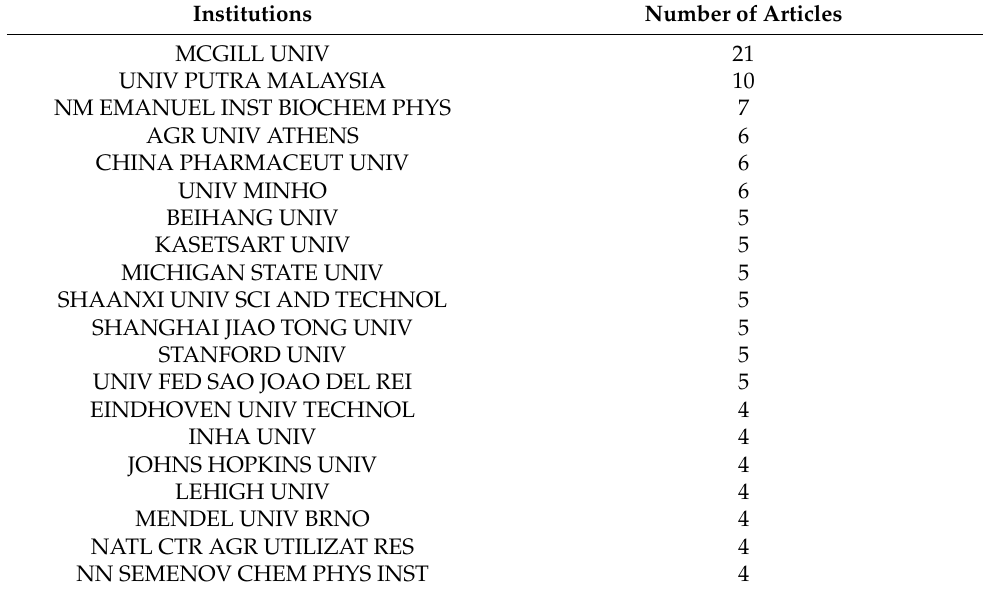
Table 2. Top relevant institutions in biodegradation-of-plastics-related research between 2000 and